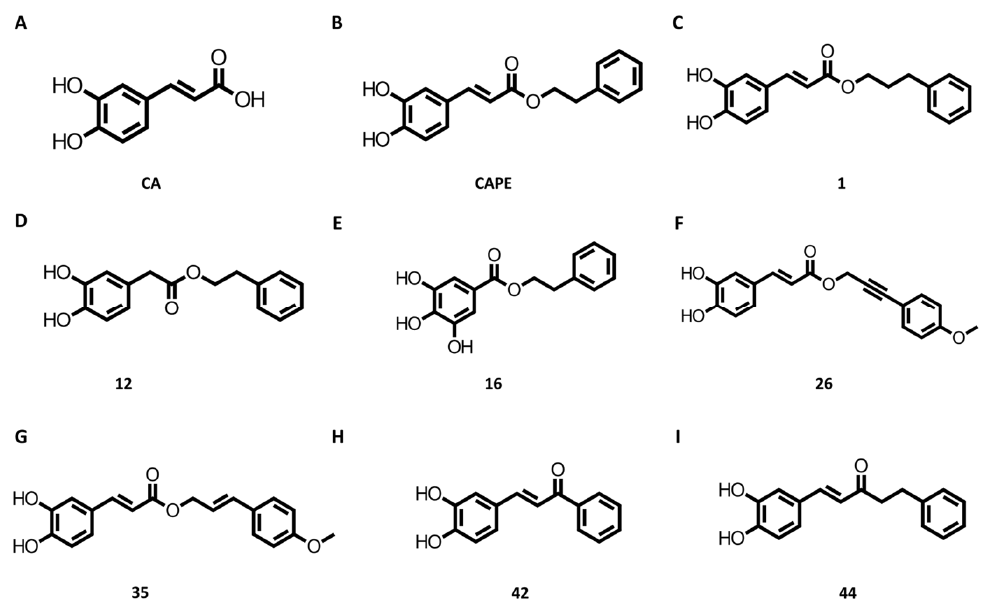
Figure 2. Chemical structures ( A – I ) of key antioxidant esters and ketones of selected phenolic ac- ids.